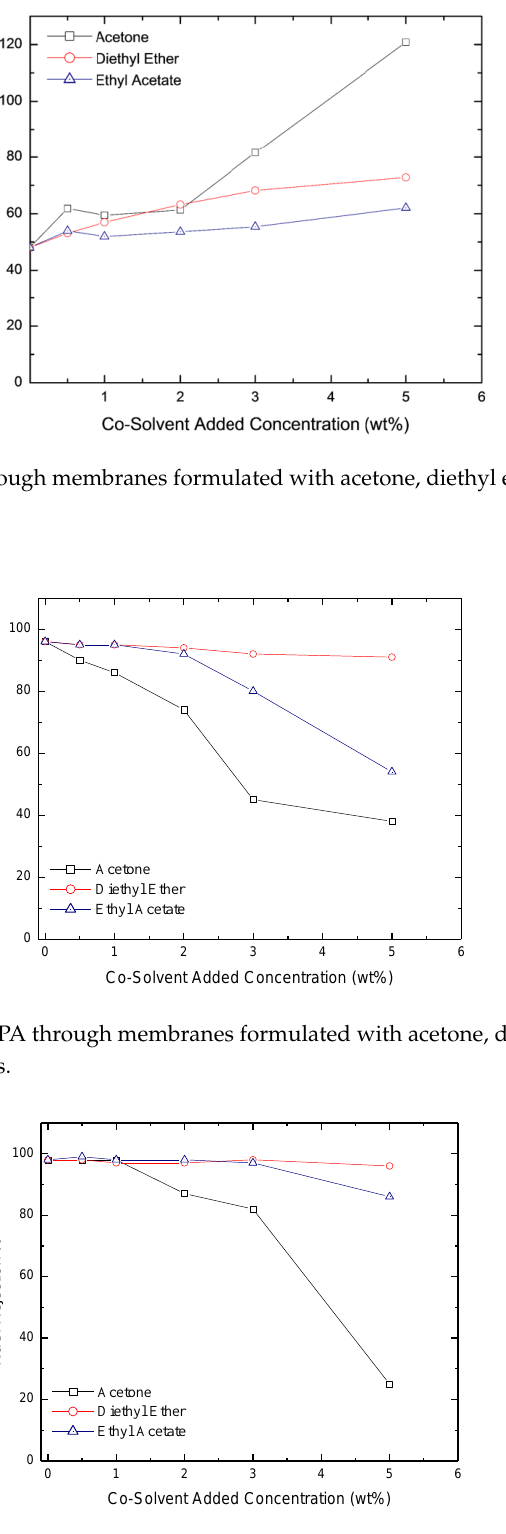
Figure 11. Experimentally measured salt rejection of NaCl through membranes formulated with acetone, diethyl ether, and ethyl acetate added as co-solvents.